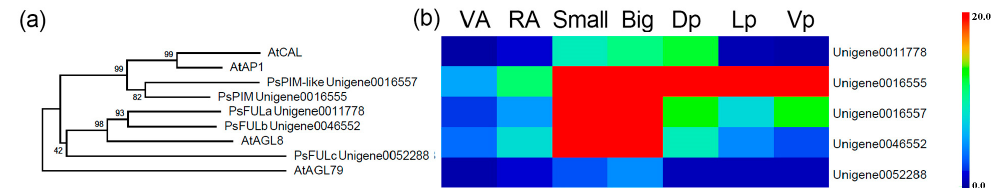
Figure 5. A neighbor-joining consensus tree and the expression patterns of the pea AP1/FUL clade MADS-box genes. ( a ) An unrooted protein tree for the AP1/FUL clade MADS-box genes using MEGA 5.0.1. Bootstrap values are denoted above the nodes. ( b ) The expression patterns of the AP1/FUL clade genes in different organs in pea. VA, Vegetative shoot apices; RA, Reproductive shoot apices; Small, 2-mm small buds; Big, 5-mm big buds; Dp, Dorsal petals; Lp, Lateral petals; Vp, Ventral petals.